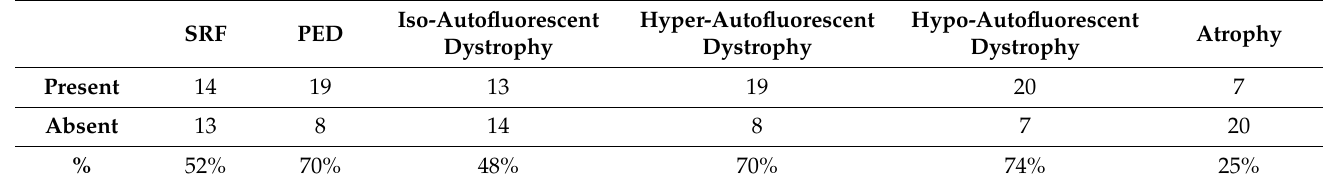
Table 1. Summary of outer retinal features detected by multimodal imaging for the characterization of our study population. Outer retinal features detected in our study population. Multimodal imaging included: fundus retinography, fundus fluorescein angiography, optical coherence tomography, fundus autofluorescence and scanning laser ophthalmoscopy retromode imaging. Percentage (%) is described as the ratio between number of eyes in which the feature was detected over the total number of eyes examined.